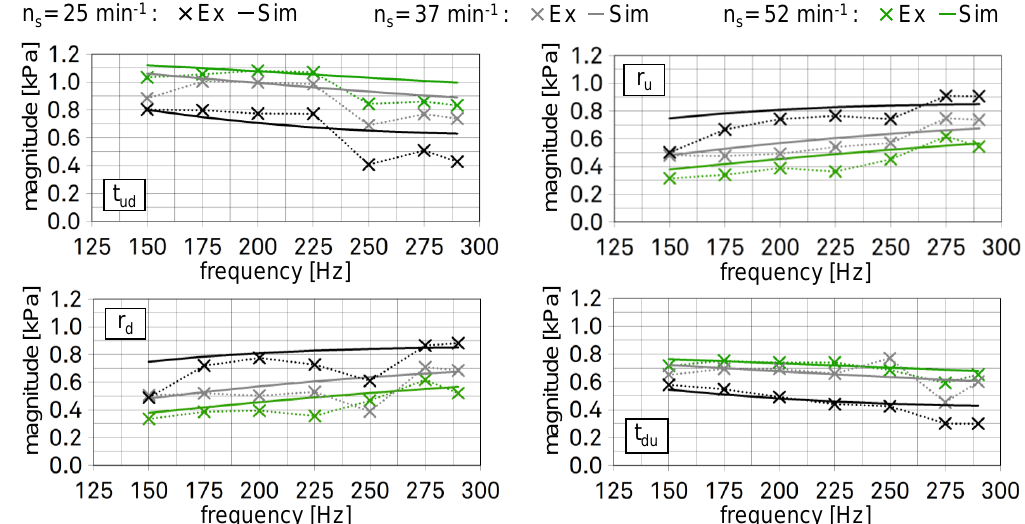
Figure 7. Comparison of experimental (Ex) and simulated (Sim) magnitudes of the transmission parameters ˆ r u , ˆ t ud , ˆ t du and ˆ r d as a function of frequency for all investigated specific